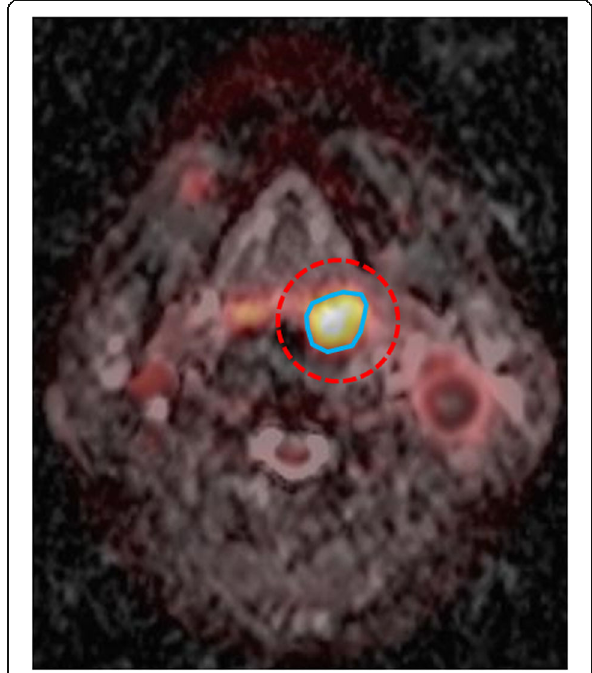
Fig. 1 Measuring methods of simultaneous 18 F-FDG PET/MRI parameters. As an initial step, the regional PET and ADC map were integrated. For the acquisition of PET parameters (SUVmax, MTV, and TLG), a spherical VOI (dashed red circle) was drawn to include the whole tumor. An isoactivity contour (solid blue circle) was automatically drawn by setting a threshold of SUV 2.5, and PET parameters were acquired. For an MRI parameter, a VOI was drawn along the isoactivity contour of PET, and the ADCmean of the tumor was